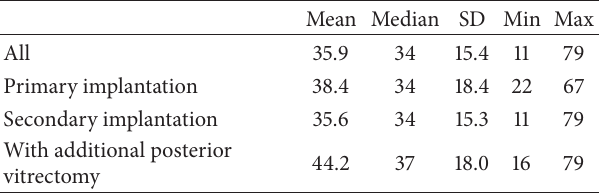
Table 5: Operation